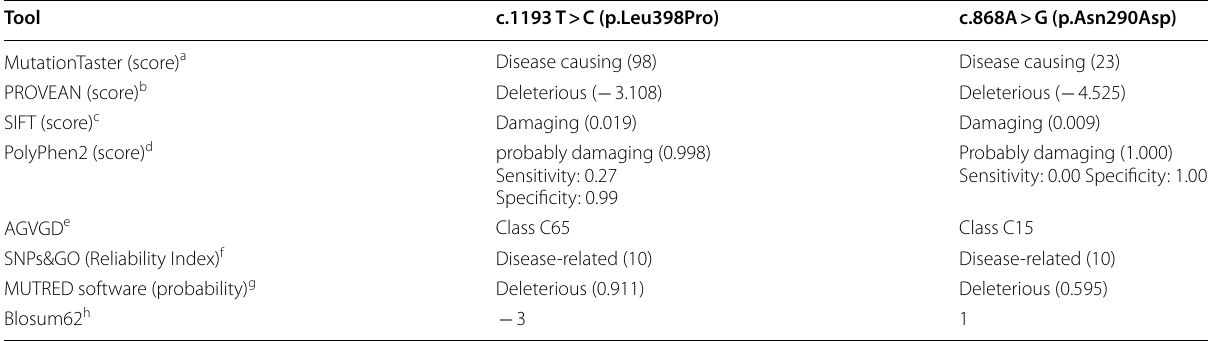
a MutationTaster score ranges from 0.0 (polymorphism) to 215 (disease causing) b Variants with score 2.5 are “damaging” and variants with score ˃ 2.5 are “neutral” ≤ − − c Variants with score 0.05 are "deleterious” and variants with score ˃ 0.05 are “tolerated” ≤ d PolyPhen2 score ranges from 0 (tolerated) to 1 (deleterious) e AGVGD classes: C0 (least likely to interfere with function), C15, C25, C35, C45, C55, C65 (most likely to interfere with function) f The SNPs&GO reliability index extends from 1 (neutral) to 10 (disease-related) g MUTPRED predictions are considered “deleterious” if the score is > 0.5 h In Blosum62 matrix, a positive score implies that substitution is more likely than any random substitution and vice